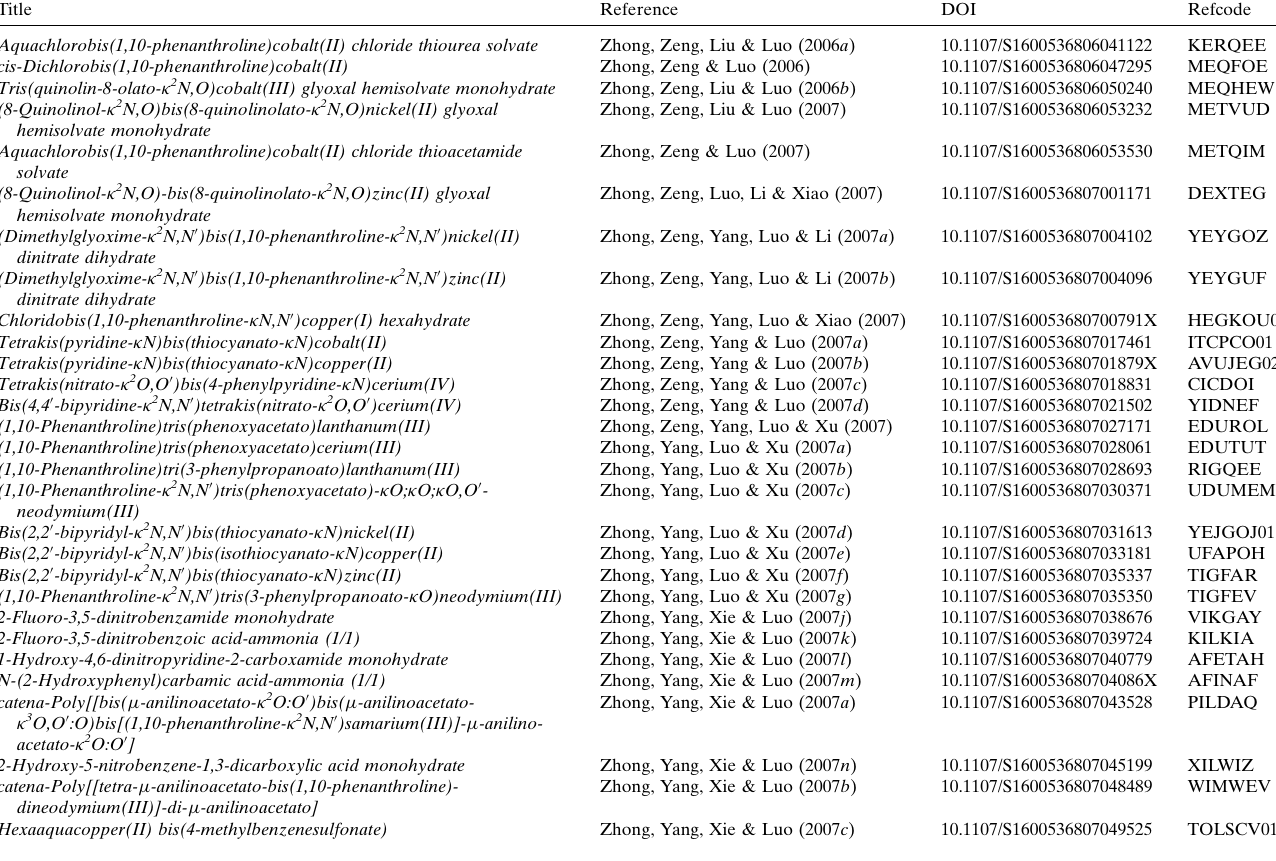
Details of articles to be retracted, in order of